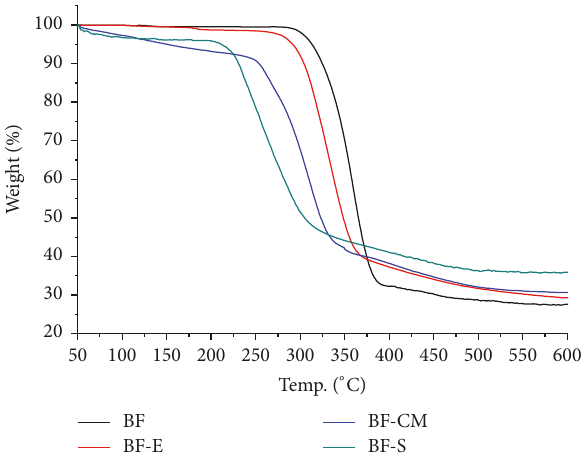
Figure 9: TGA of (a) BF (black curve), (b) BF-E (red curve), (c) BF-CM (blue curve), and (d) BF-S (green